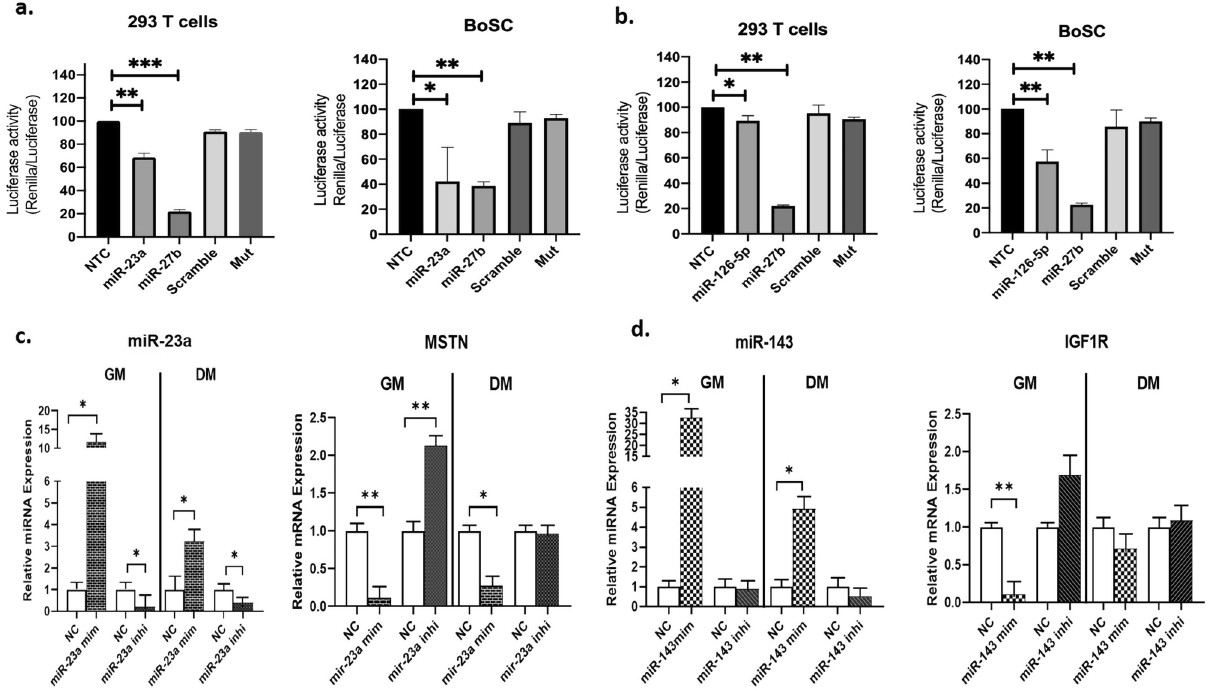
Figure 5. Luciferase assays and target gene expression analysis. 293T and BoSC were co-transfected with psi-check 2 reporter vectors containing native or mutated MSTN 3 ′ UTR and miR-23a and miR-126-5p mimics followed by cell lysis and luciferase assay 24 h later. Statistical significance was calculated for p < 0.05. NTC non-treated cells, Mut MSTN 3 ′ -UTR mutated. ( a ) Dual luciferase activity inhibition by miR-23a in 293T cells (34%, p < 0.05) and BoSC (57%, p < 0.05). ( b ) Dual luciferase activity inhibition by miR-126-5p in 293T cells (11%, p < 0.05) and BoS C (43%, p < 0.05). ( c ) Upregulation or downregulation of miR-23a levels affected the expression of MSTN gene expression in BoSC when transfected with miR-23a mimic, miR-23a inhibitor and compared with negative control (scramble). ( d ) Upregulation or downregulation of miR-143 levels affected the expression of IGF1R gene expression in proliferating myoblasts and differentiated myotubes when transfected with miR-143 mimic, miR-143 inhibitor and compared with negative control (scramble). Differences between the expression level of negative control and miR-143 mimic and inhibitor were assessed by Student t test. Differences in gene expression are shown as fold change (mean ± SEM). Significance expressed as *p < 0.05, ***p <